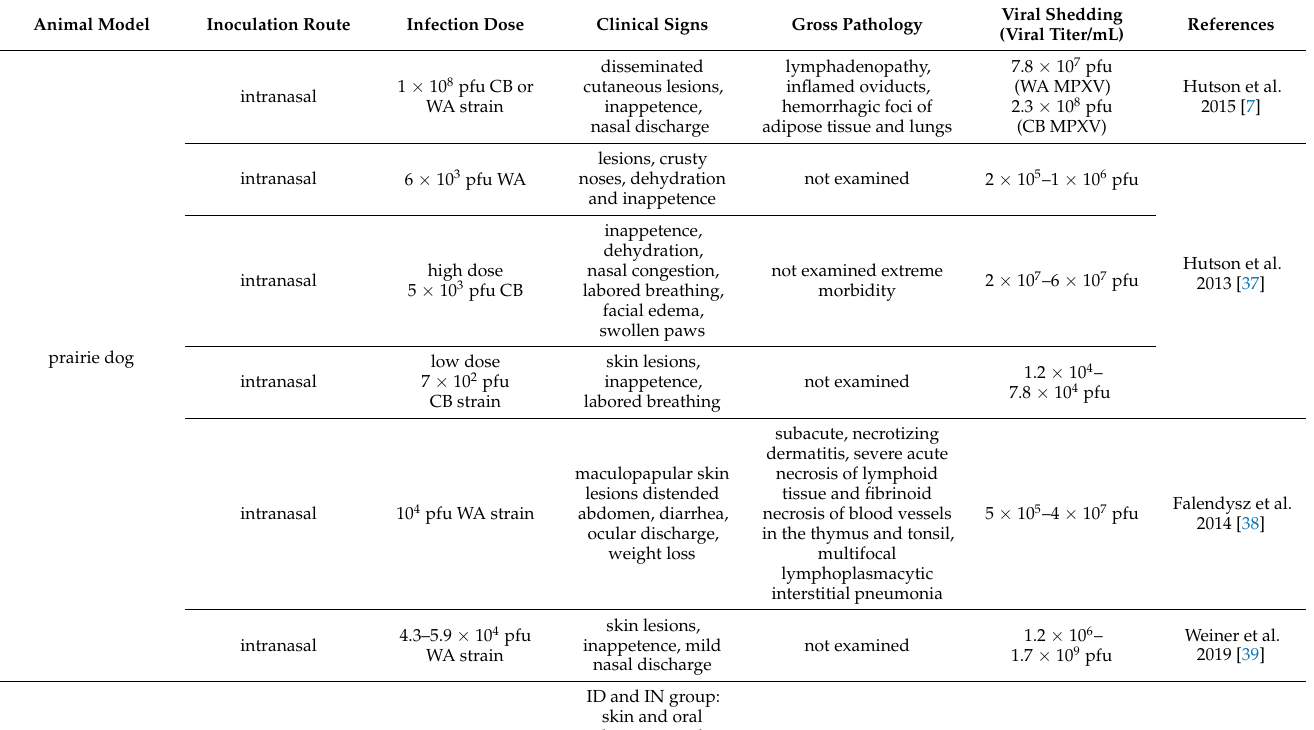
Table 1. Representation of the most often applied animal models of MPXV infection and the associated experimental